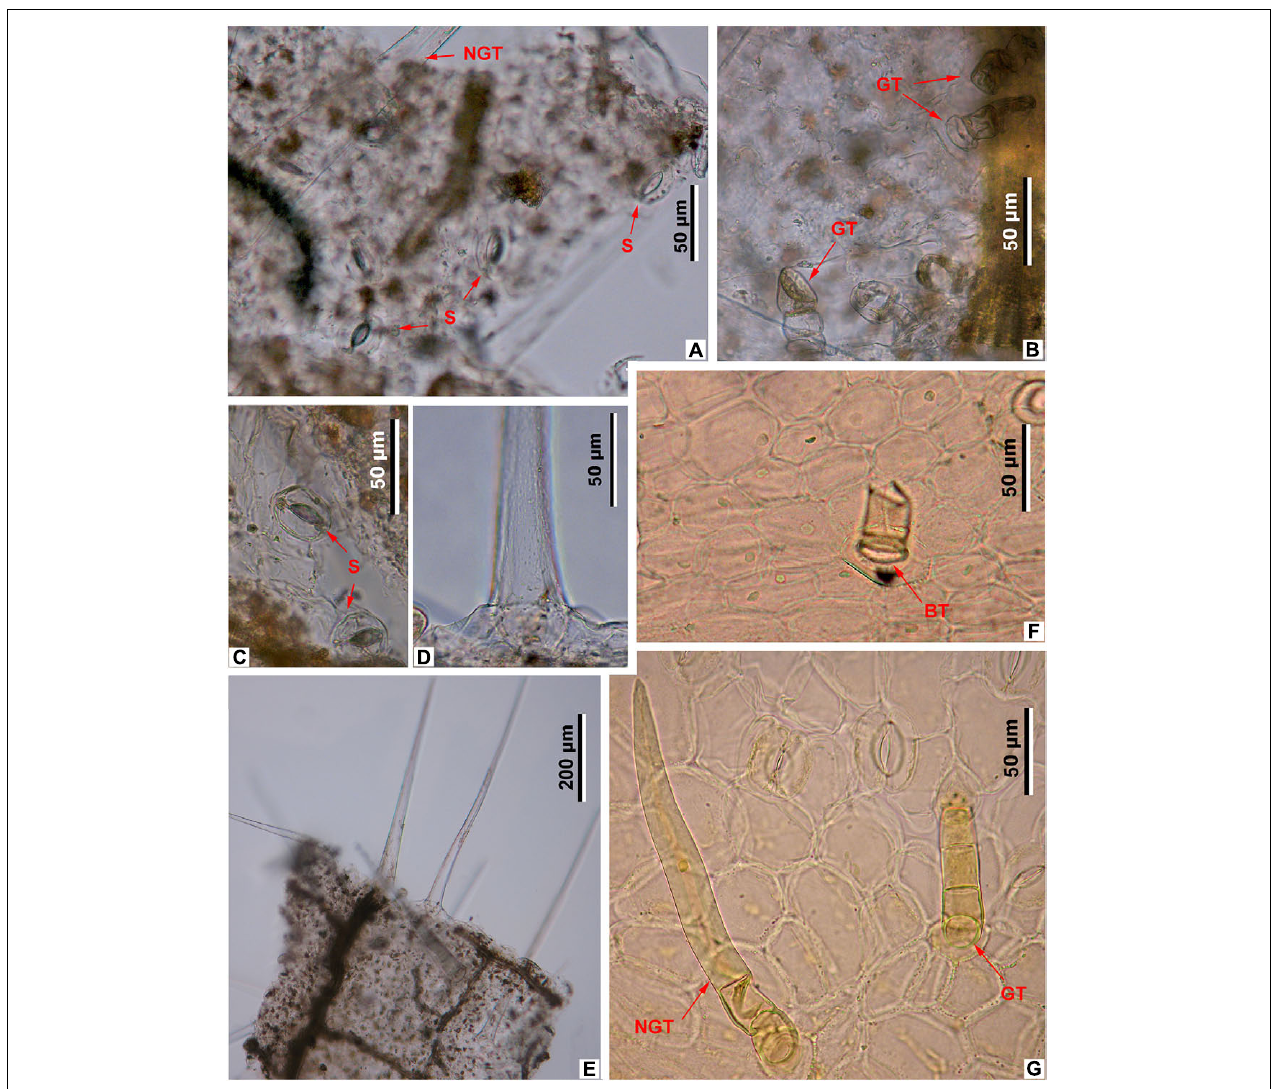
FIGURE 7 | Leaf epidermal characters of fossil and extant Meliosma , LM. M. eosinica sp. nov., MMJ3-837-3a (A–E) . (A) Abaxial surface with stomata (S) and non-glandular trichomes (NGT). (B) Adaxial surface with glandular trichomes (GT). (C) Abaxial surface with stomata (S). (D) The base of unicellular non-glandular trichome (NGT). (E) Long unicellular trichomes. Extant M. simplicifolia (Roxb.) Walp., XTBG (F,G) . (F) Adaxial surface with the base of glandular trichome (BT). (G) Abaxial surface with stomata, multicellular glandular (GT), and non-glandular (NGT)